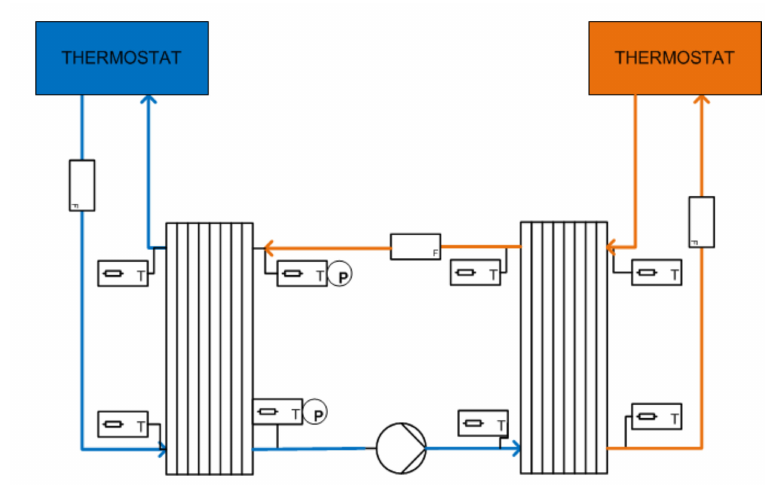
Figure 28. Schematic of stability testing device “ISE